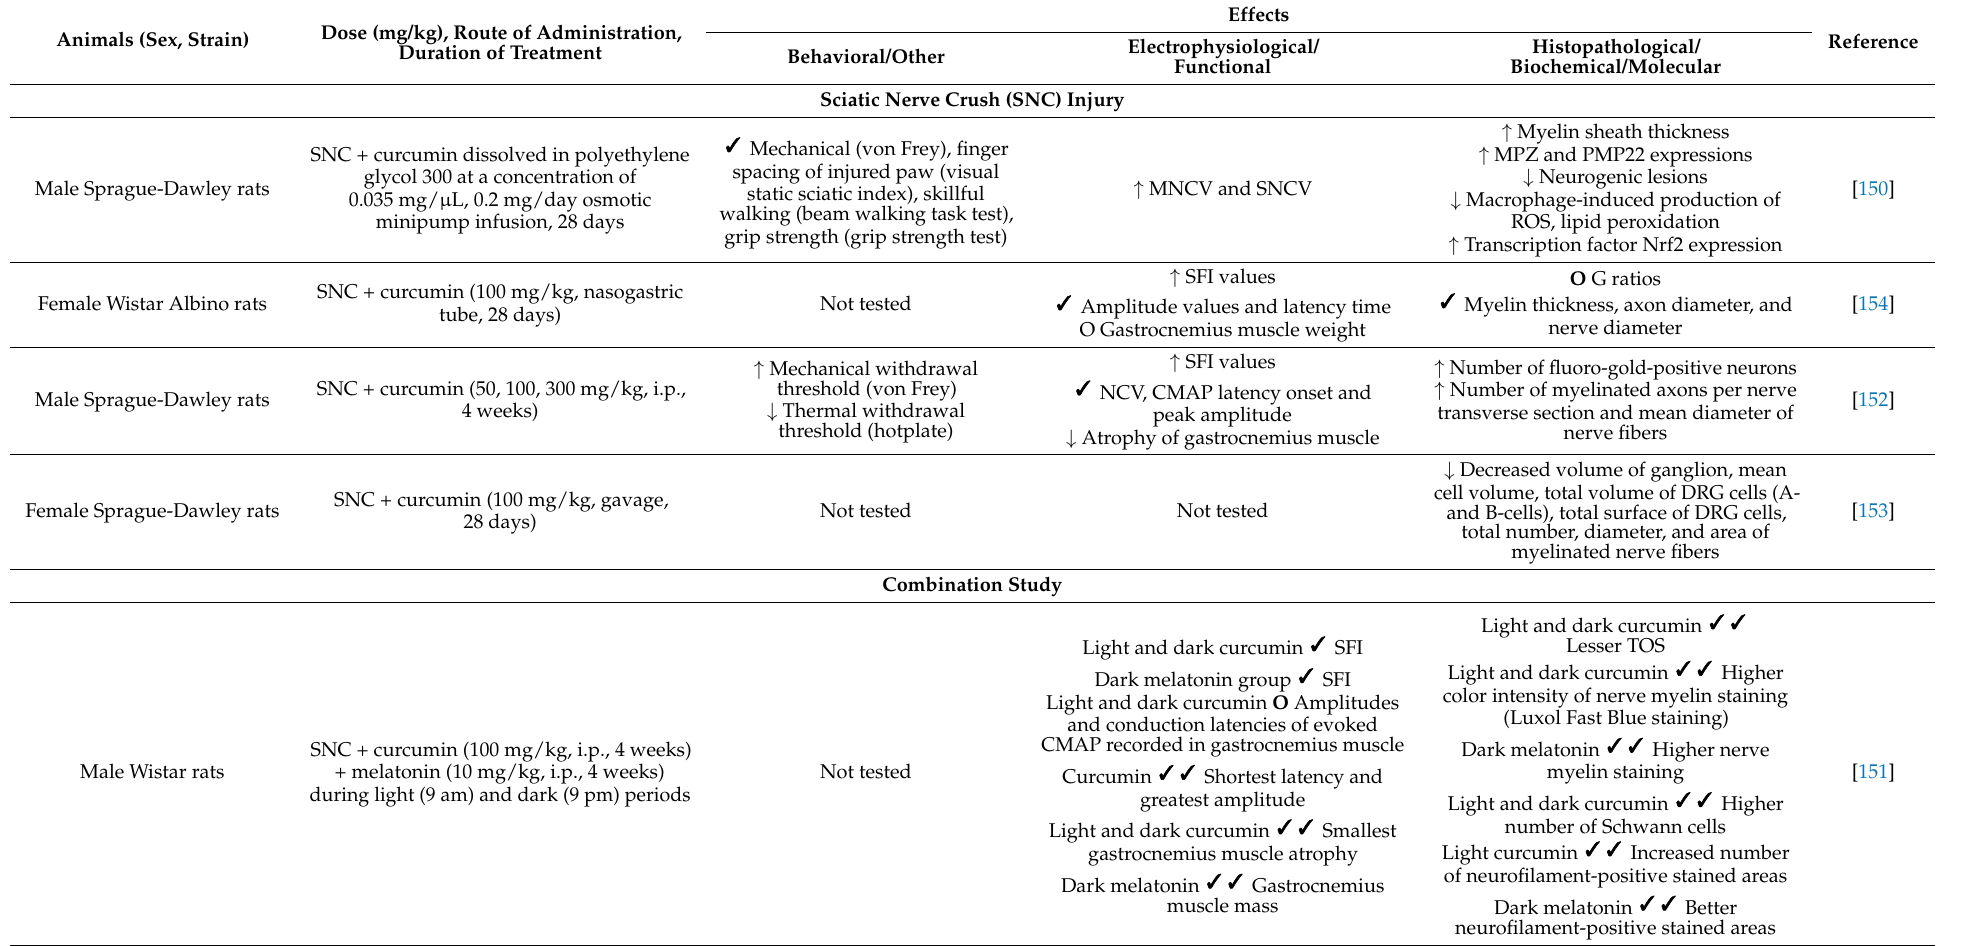
Table 2. Effects of curcumin on alcoholic neuropathy, chemotherapy-induced peripheral neuropathy (CIPN), and diabetic painful neuropathy (DPN). Animals (Sex, Dose (mg/kg), Route of Administration, Du- Table 4. Effects of curcumin on sciatic nerve crush injury (SNC), spared nerve injury (SNI), and sciatic nerve ligation (SNL). Strain)